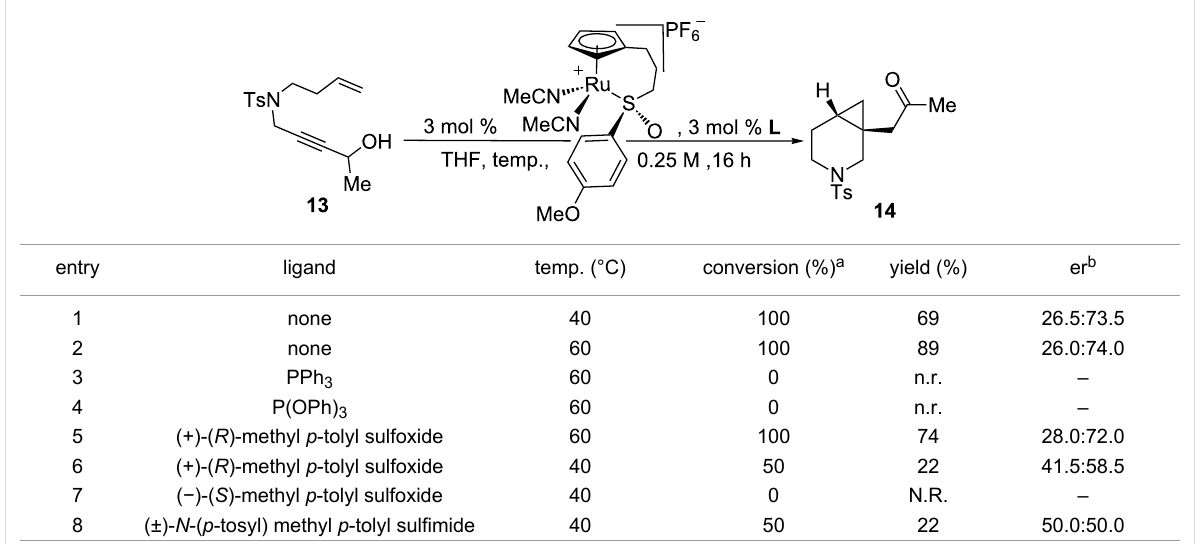
Table 1: Initial result for the asymmetric redox bicycloisomerization of 1,7-enyne 13 with chiral CpRu-sulfoxide complex 1 and the effect of added